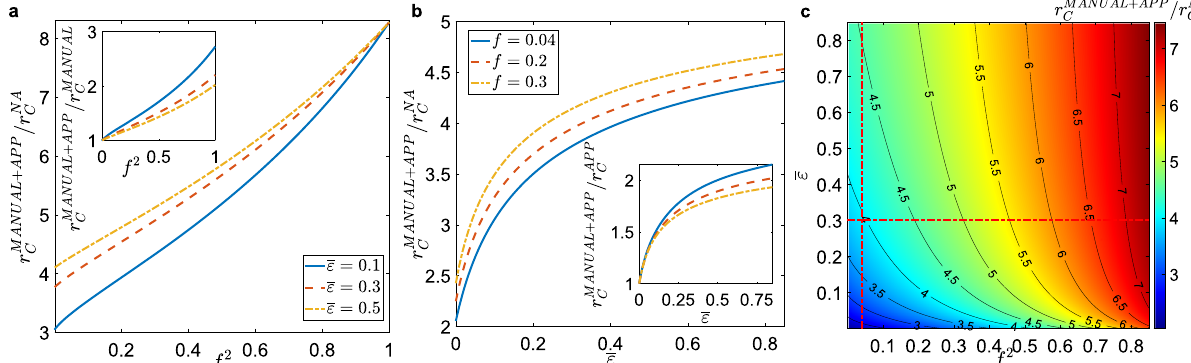
Fig. 6 Effects of hybrid contact tracing protocol. a Plot, as a function of f 2 , of the ratio between the epidemic threshold in the presence of a hybrid CT protocol, r MANUAL þ APP